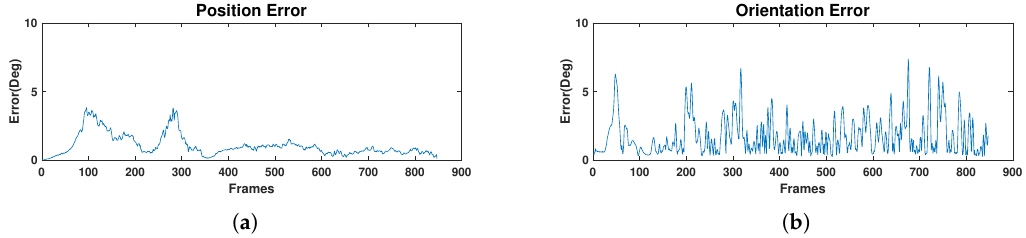
Figure 13. ( a ): Position error of the SLAM reconstruction. ( b ): Orientation error of the SLAM reconstruction. Both errors are measured in